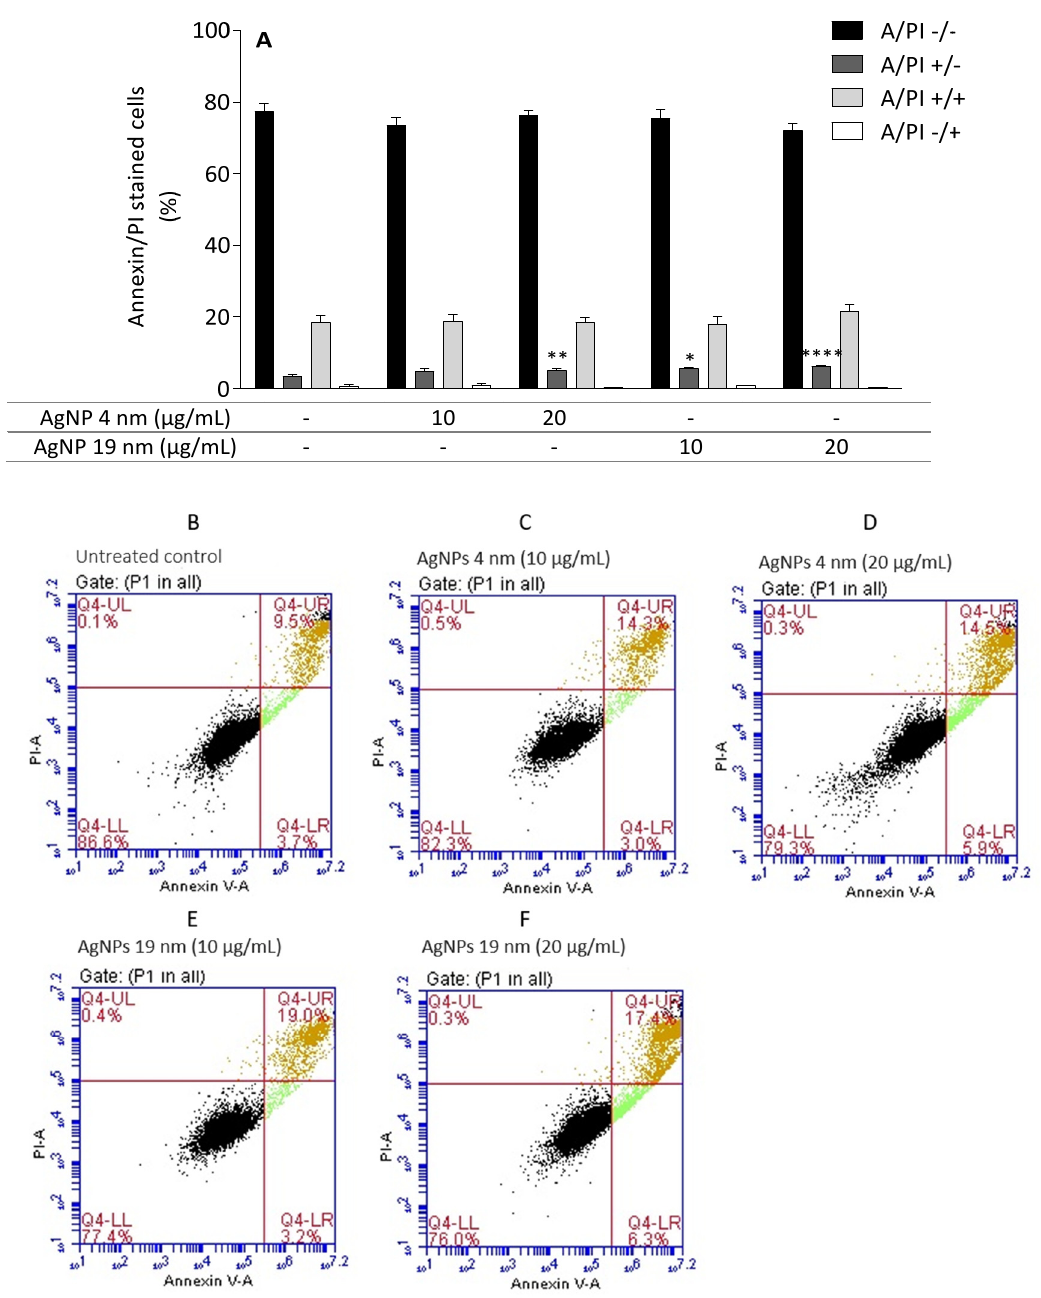
Figure 8. Apoptotic versus necrotic effects of AgNP in the Caco-2 cell line. Cells were incubated with 4 nm and 19 nm AgNP (10 and 20 µg/mL) for 24 h. Apoptotic and necrotic populations were quantified by flow cytometry with annexin V-FITC and PI. * p < 0.05, ** p < 0.01 and **** p < 0.001 when compared with the control (untreated cells) ( A ). Values are presented as the means ± SEM ( n ≥ 5). Panels ( B – F ) correspond to representative flow cytometry plots of